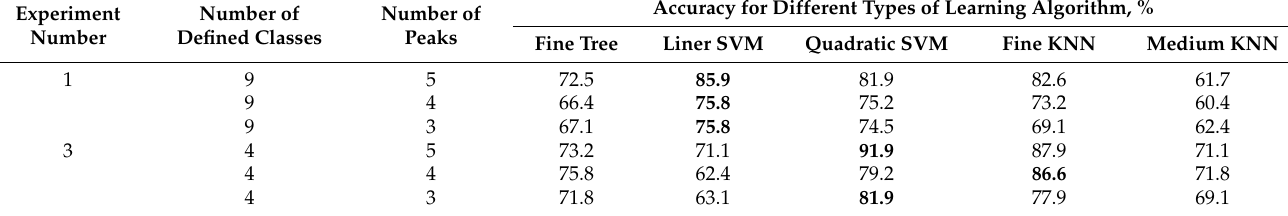
Table 3. The results of the